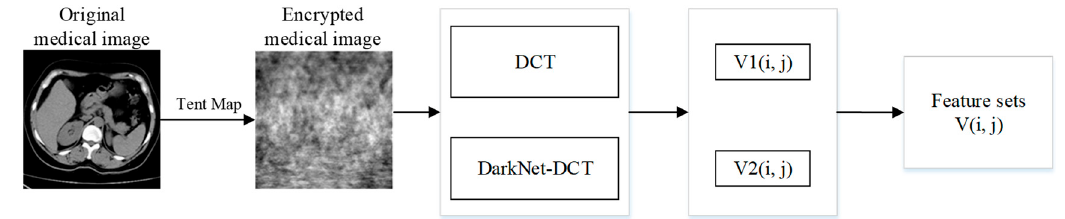
Figure 7. Extraction process of encrypted medical image features.